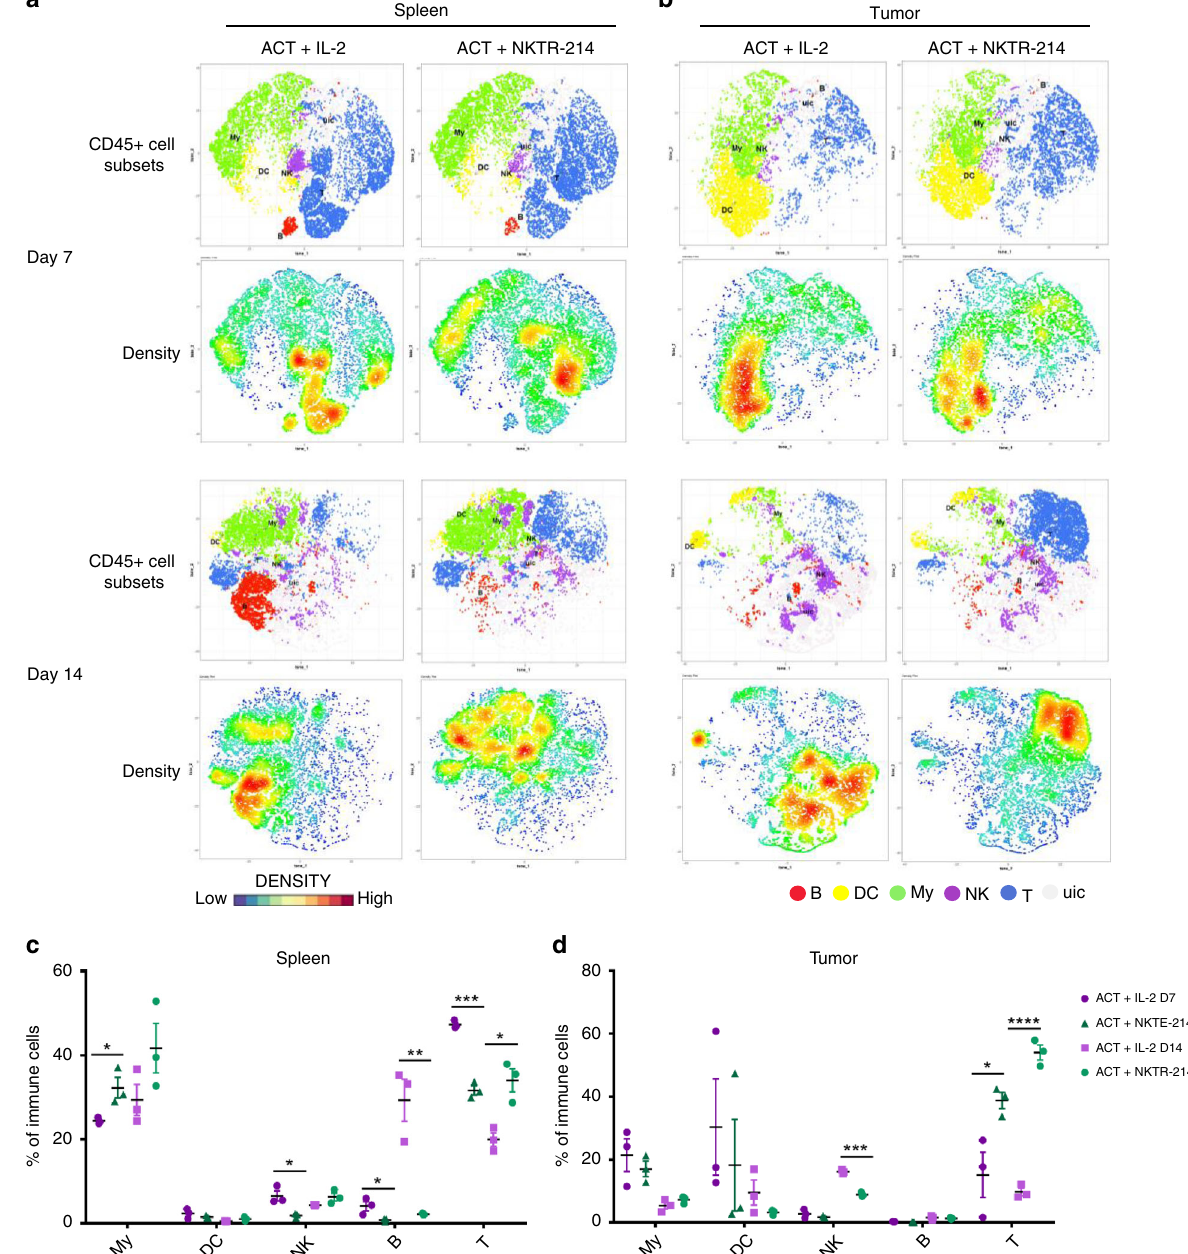
Fig. 3 Identi fi cation of differentially activated immune cells A. a , b Mass cytometry at day 7 and 14 after treatment with t-SNE plots showing annotated clusters (upper panels) and density plots (lower panels) in spleen ( a ) and tumor in mice treated with CT + NKTR-214 compared to ACT + IL-2. b Density scale bar represents marker expression of cells for a given cluster, ranging from low expression (blue) to high expression (red). In the CD45 + cell subsets panels, red dots represent B cells (B), yellow dots: dendritic cells (DC), green dots: myeloid cells (My), purple dots: natural killer cells (NK), blue dots: T cells (T), light gray dots: unidenti fi ed cluster (uic). c , d Cell frequencies were calculated for the annotated clusters and displayed on a per-mouse basis in spleen ( c ) and tumor ( d ). Mean±s.e.m ( n = 3), * p <0.05, ** p <0.01, *** p <0.001, **** p < 0.0001, unpaired t -test. The experiment is representative of two Table 1). We fi rst manually annotated seven main immune effect was particularly striking after NKTR-214 compared to IL-2 populations from CD45 + cells (Supplementary Fig. 6a) using t - at day 14 (5 days post-administration of the second dose), con- fi rming the in vivo imaging result of Fig. 2c. The NK cluster stochastic neighbor embedding (t-SNE)-generated heat maps corresponding to myeloid cells, dendritic cells (DC), NK cells, B expanded preferentially with ACT + IL-2 at day 7, and with cells and T cells (Fig. 3a, b). As expected, the clusters showing ACT + NKTR-214 at day 14 (Fig. 3a – c). T-SNE density plots greater differences between treatments were T cell populations, showed that IL-2 led to preferential B cells expansion in spleen, both in spleen and tumor (Fig. 3a – d). Additionally, in the spleen on days 7 and 14 (Fig. 3a). Interestingly, dendritic cell popula- the myeloid compartment was increased at day 7 and 14 by ACT tions represented an important fraction of the tumor immune + NKTR-214 treatment (Fig. 3a – c). The robust re-treatment cells in both ACT + IL-2 and ACT + NKTR-214-treated mice at